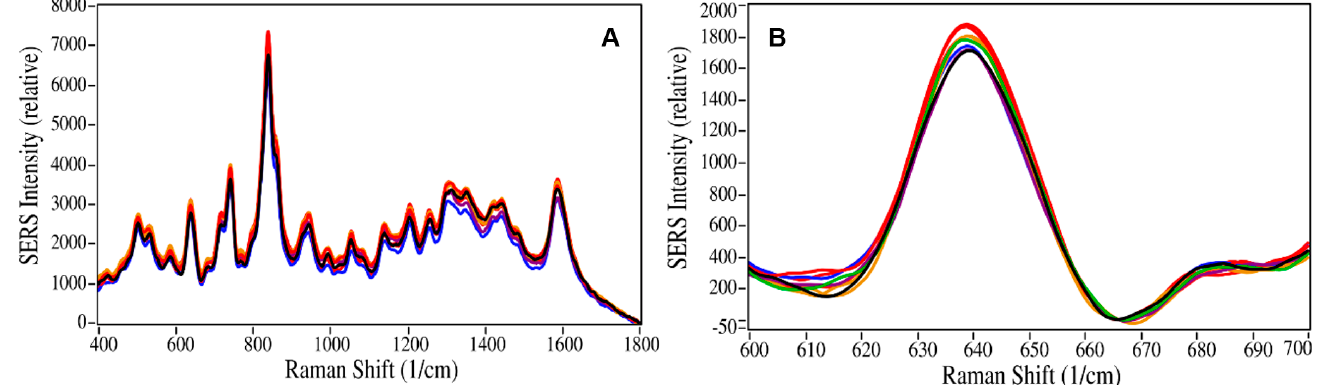
Figure 6. Nine overlaid SERS of 50 ng/mL buprenorphine extracted from prepared pooled saliva samples, ( A ) baseline-corrected at 1800 cm − 1 , and ( B ) baseline-corrected at 665 cm − 1 . Conditions as in Figure 1.